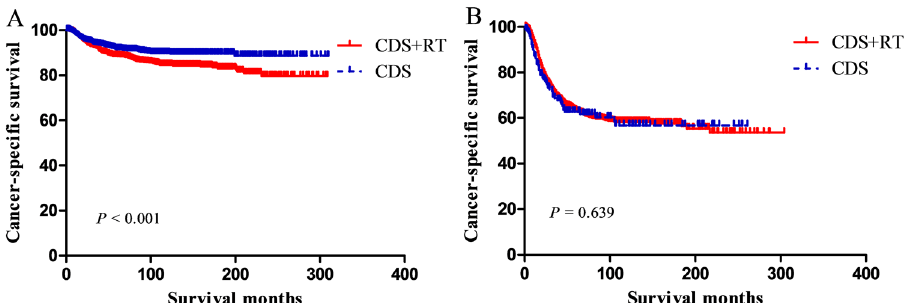
Figure 2. Cause-specific survival of patients with FIGO stage IB-IIA ( A ) and IIB ( B ) with different local treatment modalities in the matched